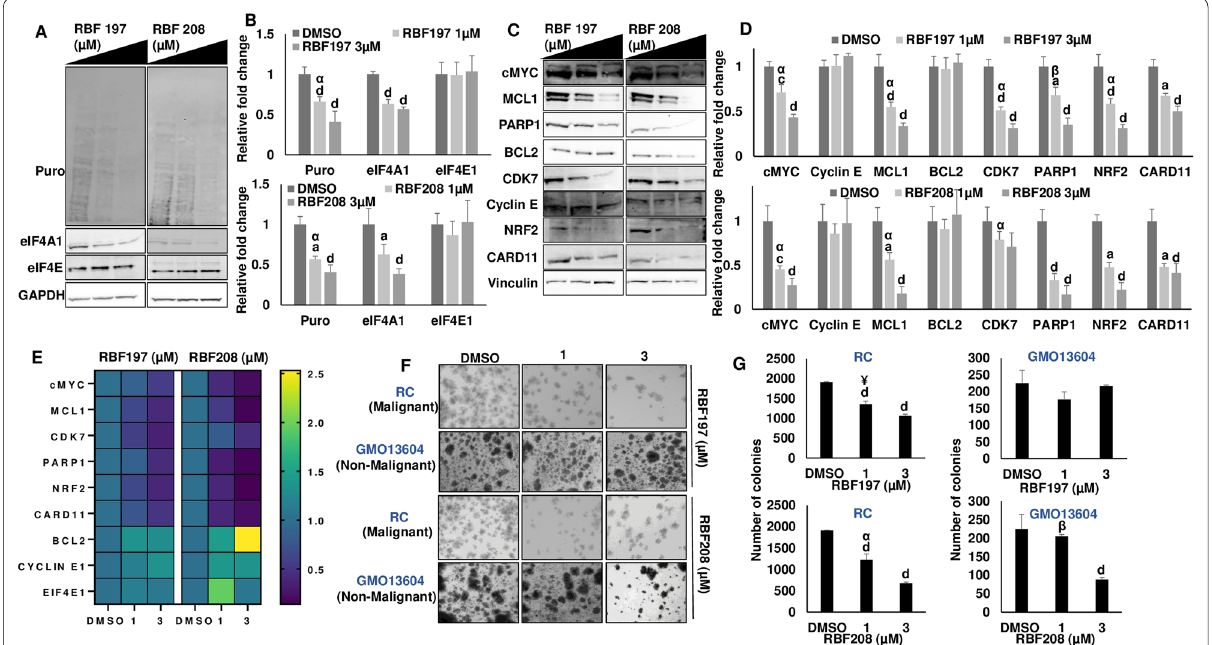
Fig. 6 RBF197 and RBF208 decreases overall translation and eIF4A1 dependent pathway proteins in double-hit lymphoma. A SUnSET assay was performed by exposing cells to puromycin (1 μg/mL), post compound treatments for 30 min, and subsequently lysed. Representative immunoblots were probed with anti-puromycin, anti-eIF4A, and anti-eIF4E. GAPDH was probed as an internal loading control. B Relative fold change in expression levels with on treatment of RBF197 or RBF208 at 1 and 3 µM concentrations. C Representative immunoblots of cMYC, MCL1, PARP1, BCL2, CDK7, NRF2, Cyclin E and CARD11 on treatment with RBF197 and RBF208 at 1 and 3 µM concentrations respectively. Vinculin was used as a loading control. D Relative fold change in protein levels of the above-mentioned proteins with on treatment of RBF197 and RBF208, respectively. E Heat map of translation efficiency values for RBF197 and RBF208 in RC cell line. F Effect of RBF197 and RBF208 on DLBCL colony formation. Representative image of the colony formation in RC (malignant) and GMO13604 (non-malignant) cells. G The total number of colonies grown in RC, and GMO13604 cells upon treatment with 1 and 3 µM of RBF197 and RBF 208, respectively. All treated groups were normalized with DMSO controls and expressed as mean SD (n 3). Statistical analysis was performed using one-way ANOVA followed by Bonferroni’s correction analysis. a p < 0.05; ± = c p < 0.001, d p < 0.0001 vs DMSO control groups, α p < 0.05, β p < 0.001, ¥ p < 0.0001 vs 3 μM treatment